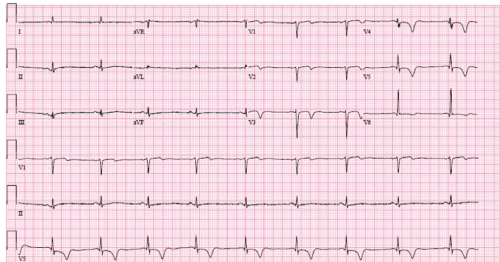
Figure 1: 12-lead ECG at presentation demonstrating new antero- lateral T-wave inversions.